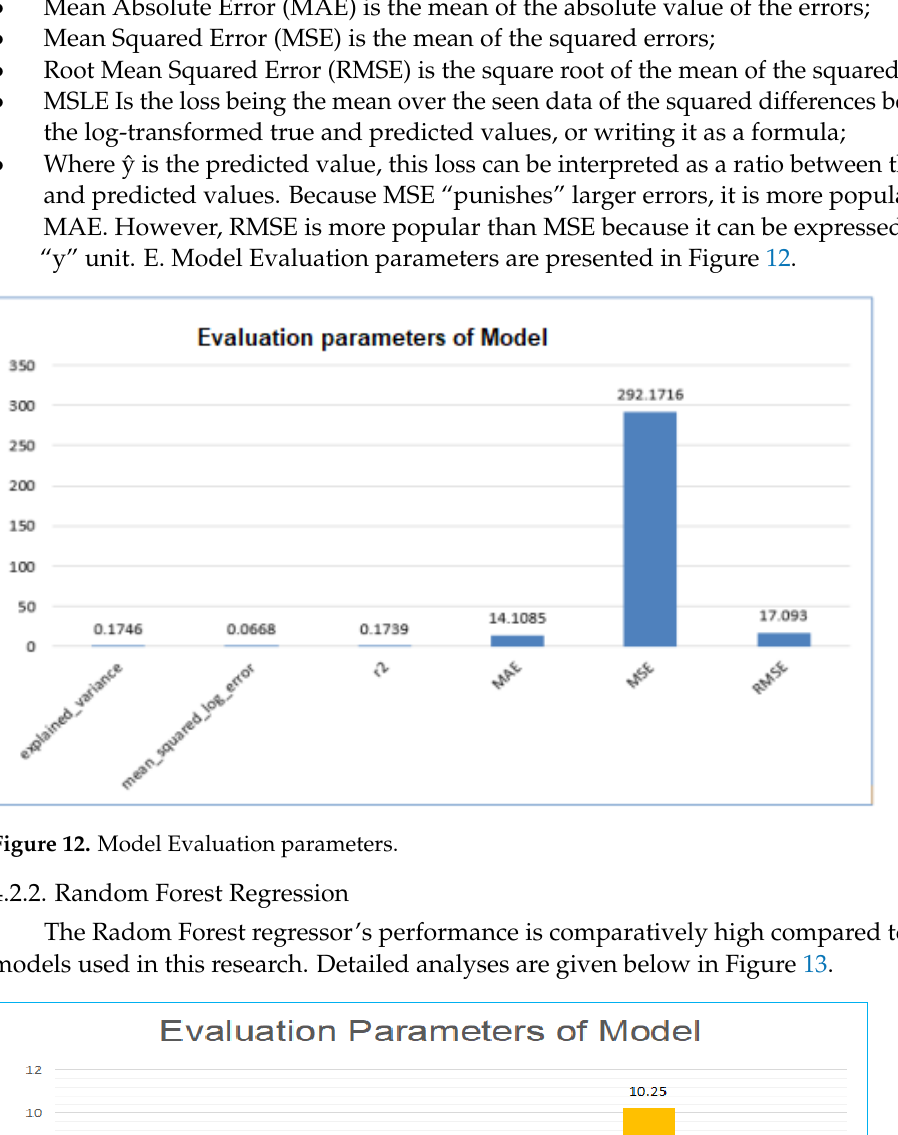
Figure 14. DT Performance. 4.2.4. Models Summary A comparative Summary of Models MLR, RF, and DT are presented in Figure 15.